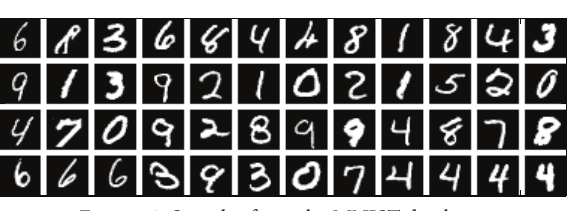
Figure 3: Samples from the MNIST